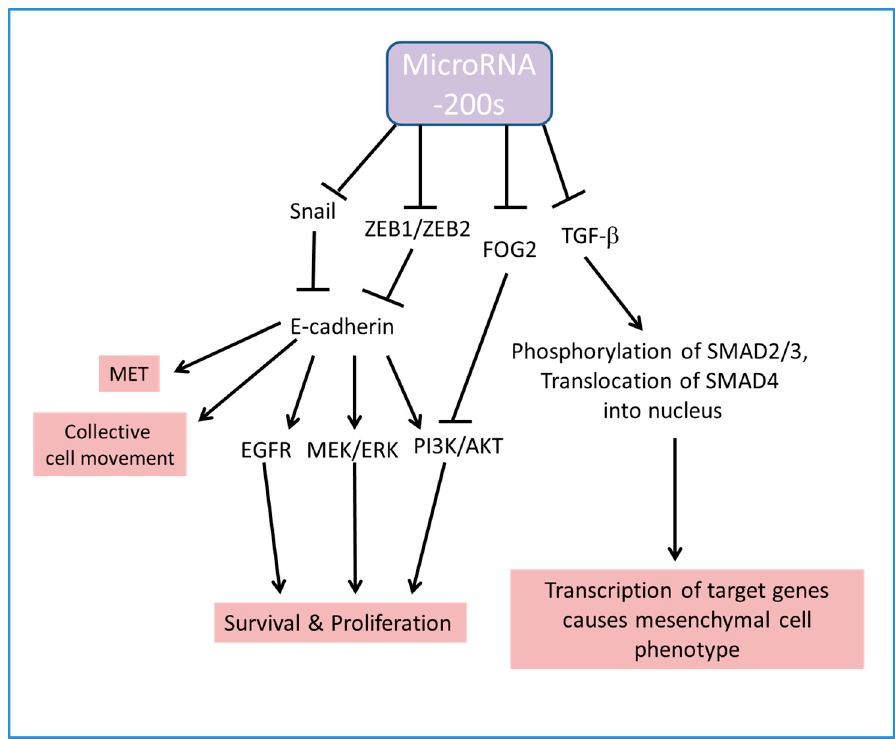
Figure 1. Schematic diagram showing miR-200s target E-cadherin and TGF- β for tight regulation on mesenchymal-epithelial-transition (MET), cell migration and cell survival.